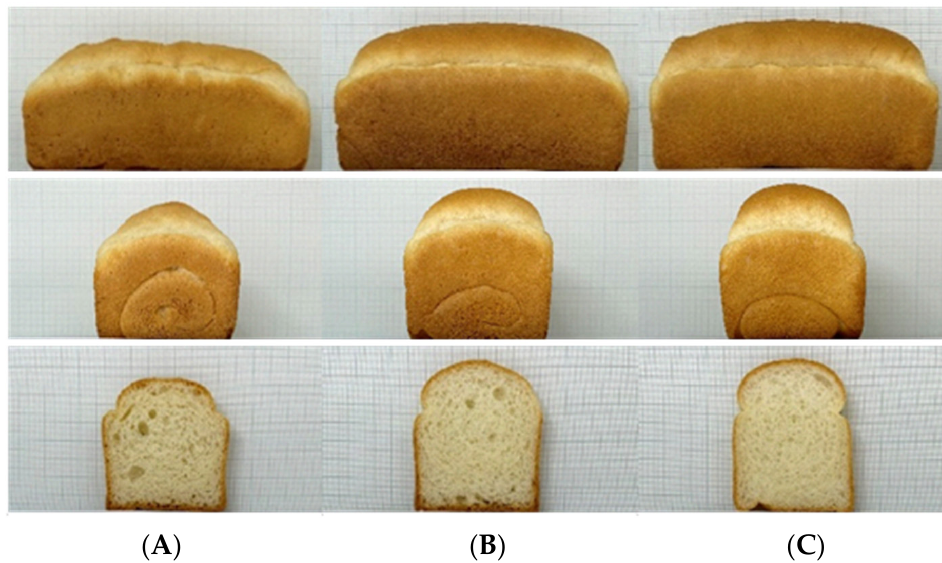
Figure 4. Side and cross-section views of bread made with the flour samples: ( A ), ‘O-free’ flour; ( B ), Bread flour A; ( C ), Bread flour B.